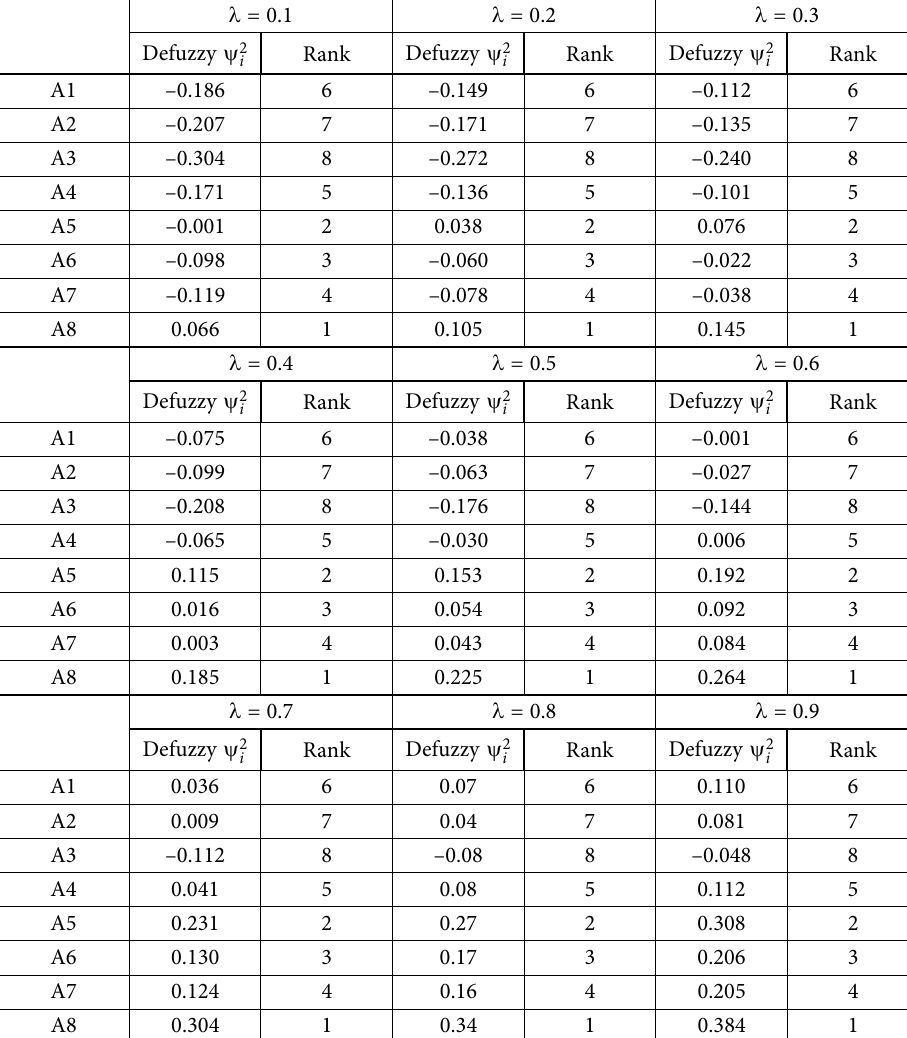
Table 13. Analysis of the impacts of the λ coefficient on the ranking